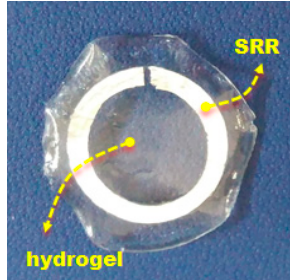
Figure 3. A photograph of an SRR embedded in the hydrogel matrix.